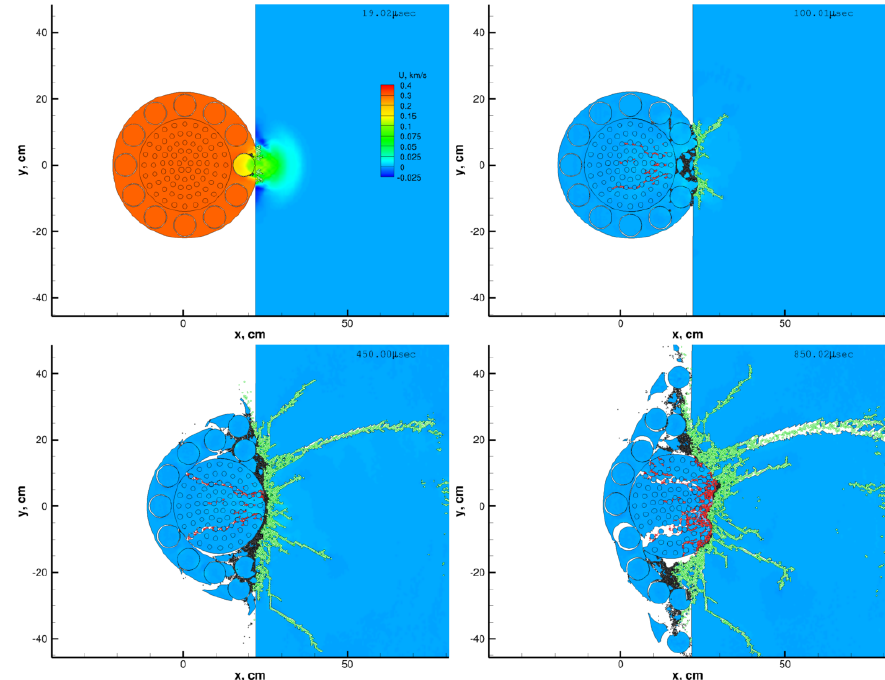
Figure 11: Frames of the calculated side impact of the reactor model onto the granite plate